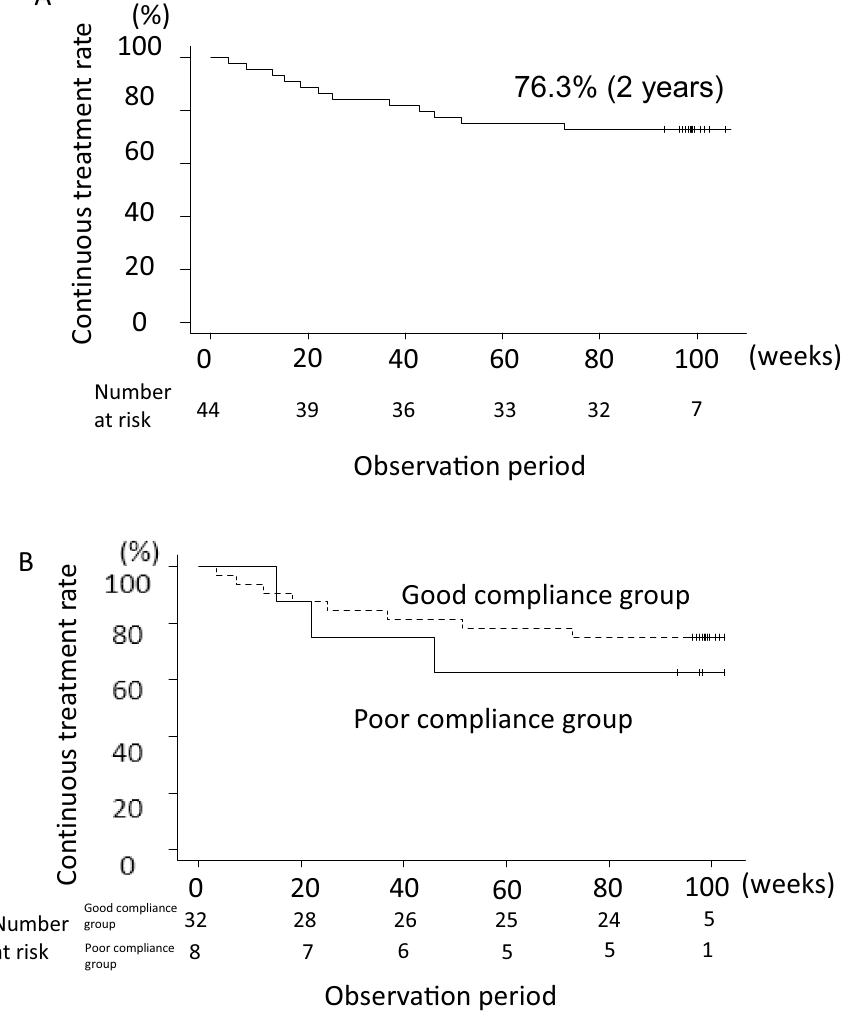
Figure 2. Survival curve of the continuous treatment maintenance rate of mesalazine granule preparation. ( A ) Overall. ( B ) Comparison between the good compliance group (dotted line) and the poor compliance group (solid